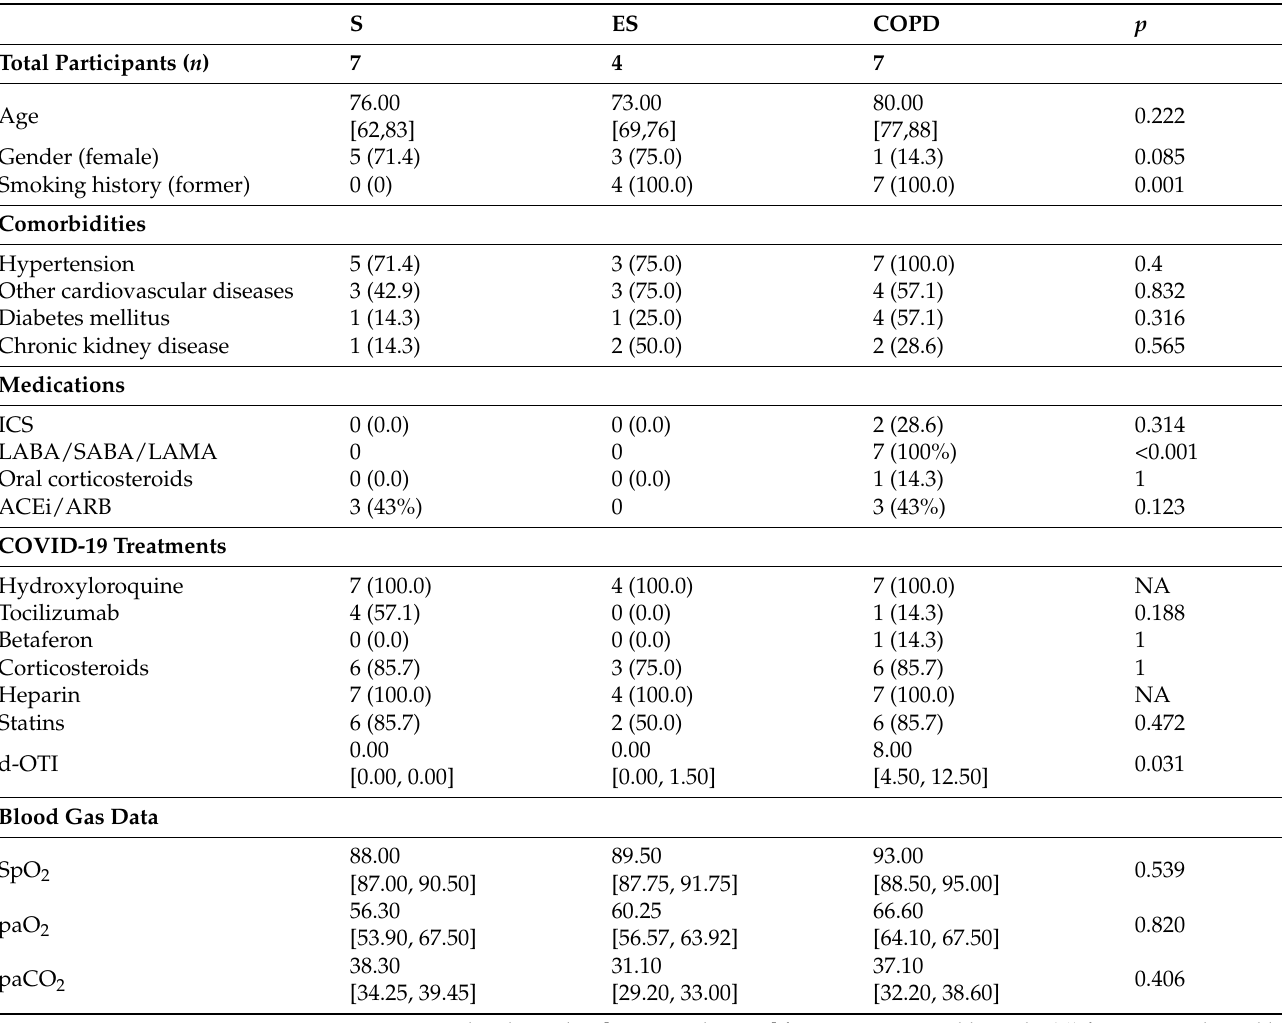
Table 1. Demographic and clinical characteristics of patients who died of